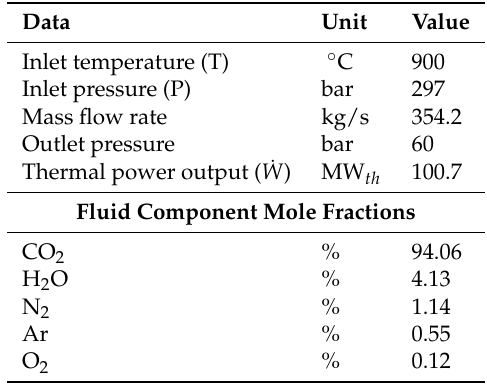
Table 4. Radial turbine boundary conditions from cycle